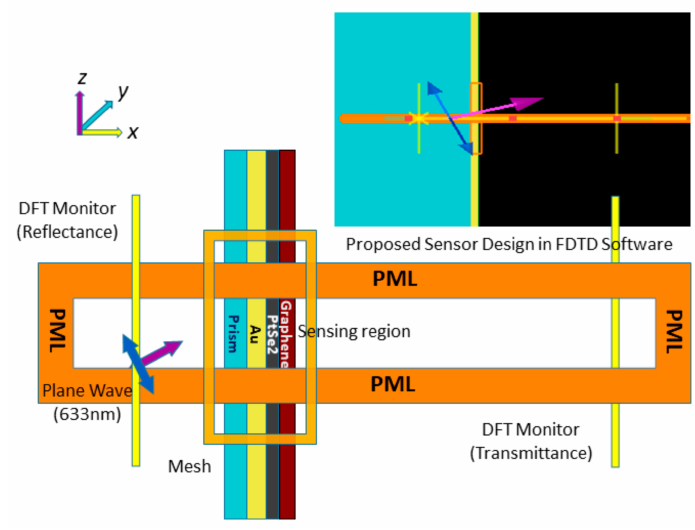
Figure 4. FDTD simulation schematic for the proposed SPR